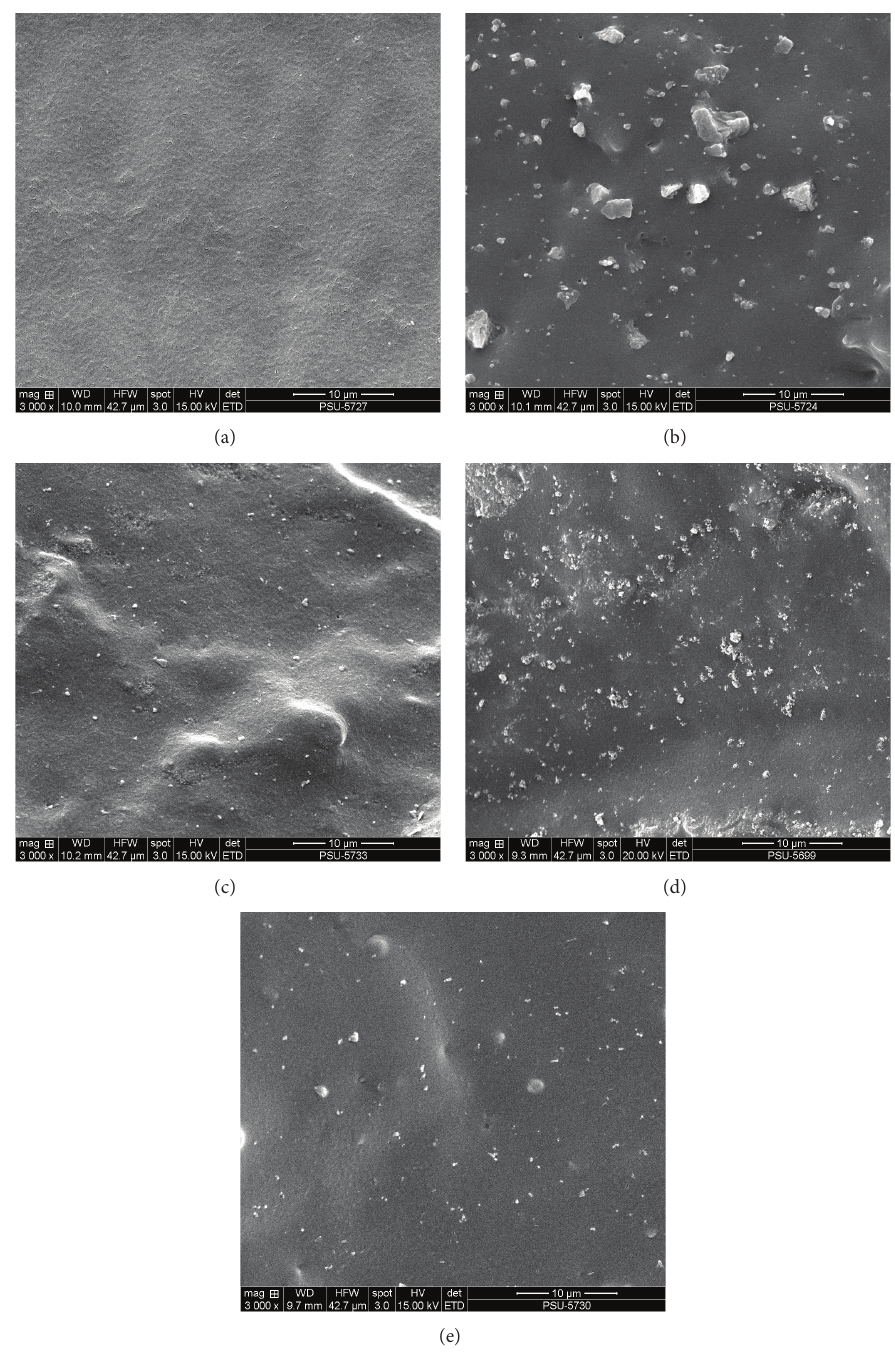
Figure 14: SEM micrographs of gum and filled ENR-25 vulcanizates with 30 phr of RHA and silica with and without silane coupling agent (Si69): (a) gum vulcanizates; (b) RHA 30 ; (c) RHA 30 -Si69; (d) S 30 ; (e) S 30